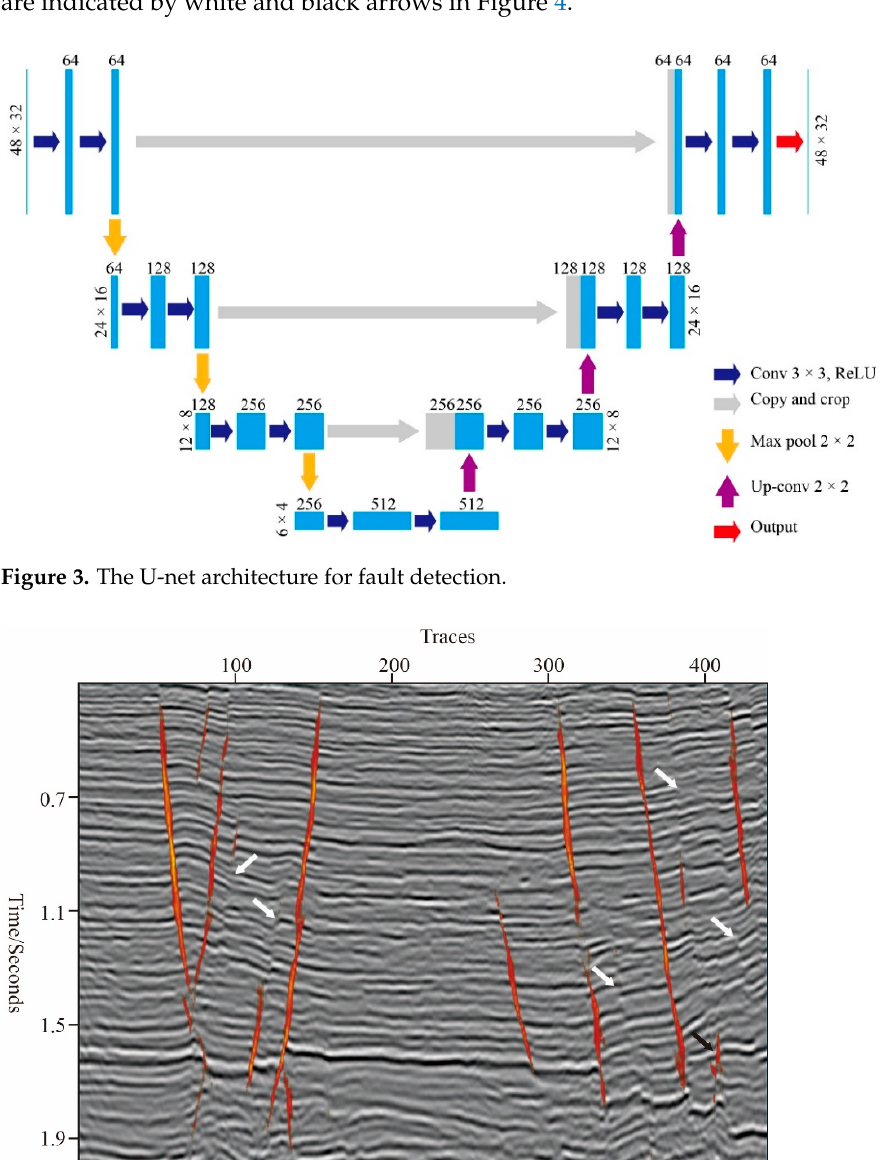
many faults that have not been detected, and there are also some misidentifications, which